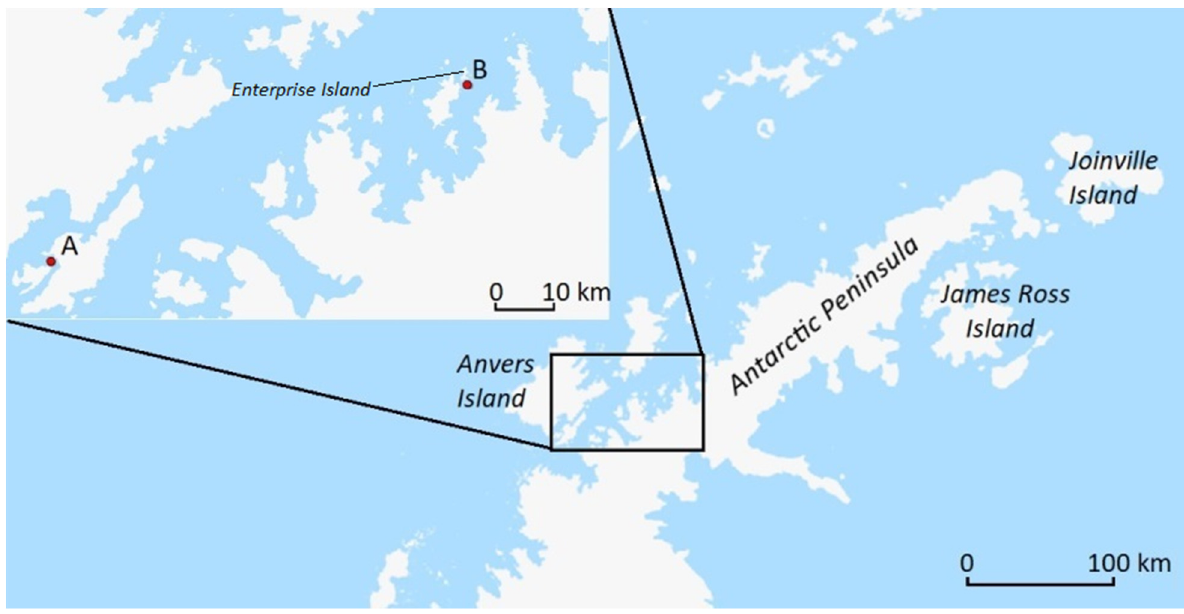
Figure 1. Map showing the locations of sampling sites from which Belgica antarctica larvae were obtained: A—Jougla Point, B—un-named island near Enterprise Island.